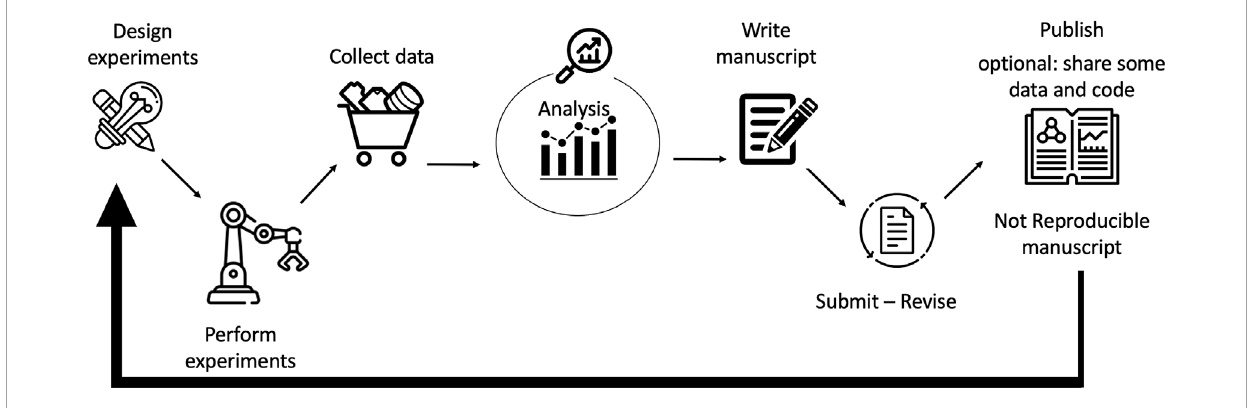
FIGURE 1 Not-reproducible research lifecycle: from designed and executed experiments, collection and analysis of data are performed from which a manuscript is written, submitted, revised, and eventually published. Optionally, together with the manuscript, data and source code are also made available. From the results obtained, a new hypothesis and experiments can be drawn. It is not possible to reproduce the experiments described in the published paper.